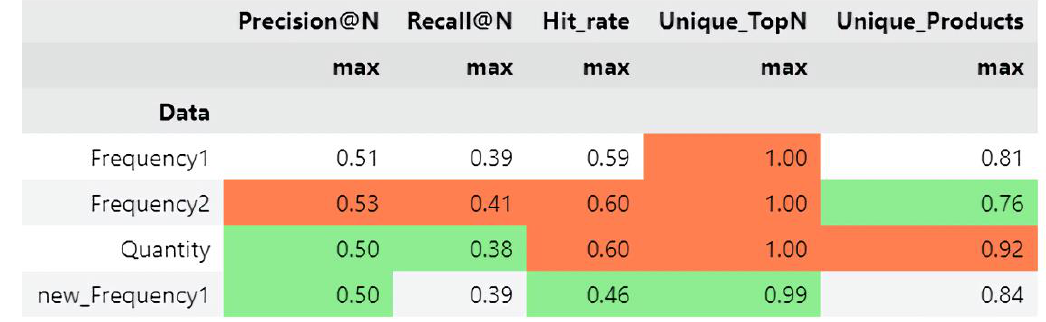
Figure 13. LightFM best evaluation results